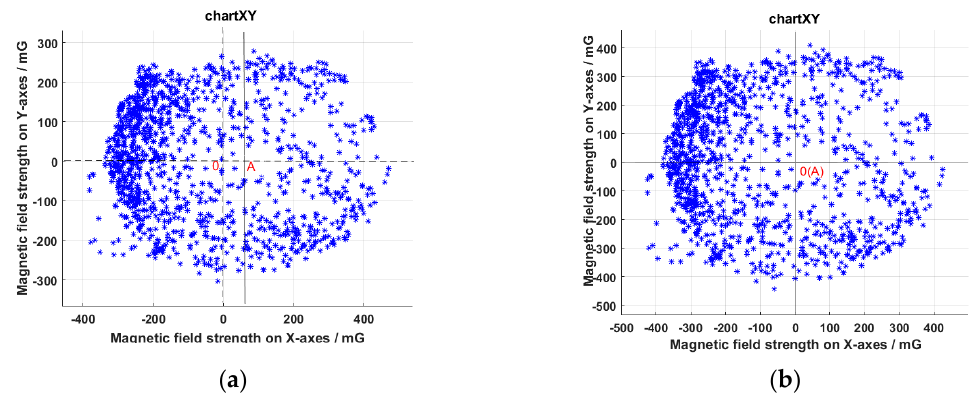
Figure 8. Magnetic field projected on the XY plane: ( a ) uncorrected data; and ( b ) corrected data.